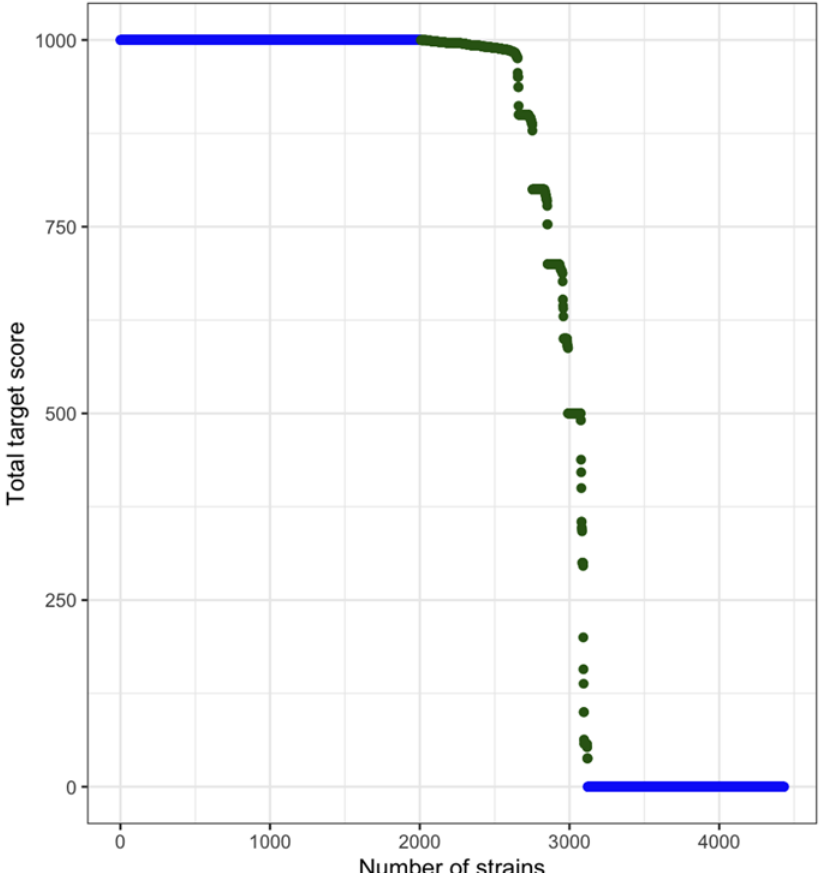
Figure 1. Overview of number of strains of Salmonella Infantis that harbored targets associated with the pESI plasmid; all ten targets at a coverage of 100% resulted in a score of 1000 and classified the plasmid as present. Strains that had no coverage of a target (0) were classified to not carry the plasmid. Strains with intermediate scores (pictured here in green, score 1 to 999) were removed from the analysis.